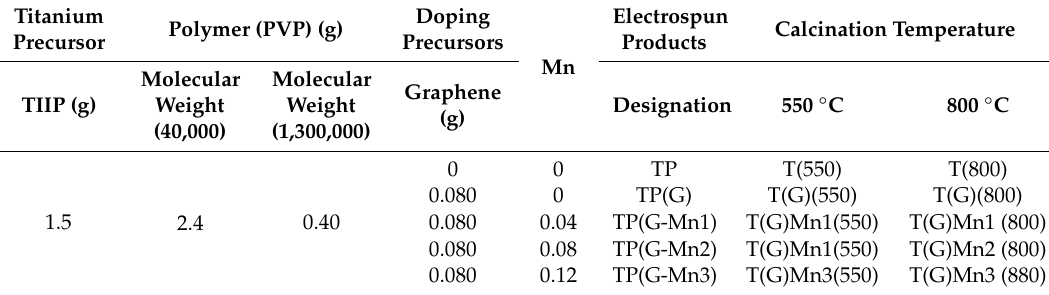
Table 1. Electrospun dope compositions and product